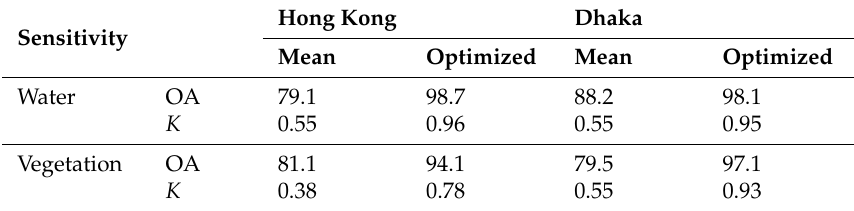
Table 6. Impact of the parameter threshold of the TCWVI on detection of water and vegetation. Hong Kong Dhaka Sensitivity Mean Optimized Mean Optimized Water OA 79.1 98.7 88.2 98.1 K 0.55 0.96 0.55 0.95 Vegetation OA 81.1 94.1 79.5 97.1 K 0.38 0.78 0.55 0.93 Note: OA, overall accuracy and K , kappa